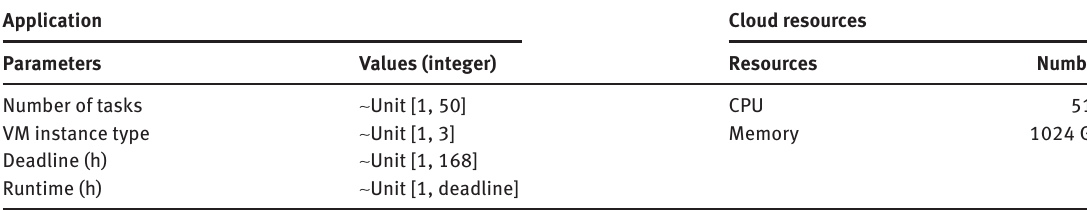
Table 11: Parameters of Problem Instances 2 and 3.